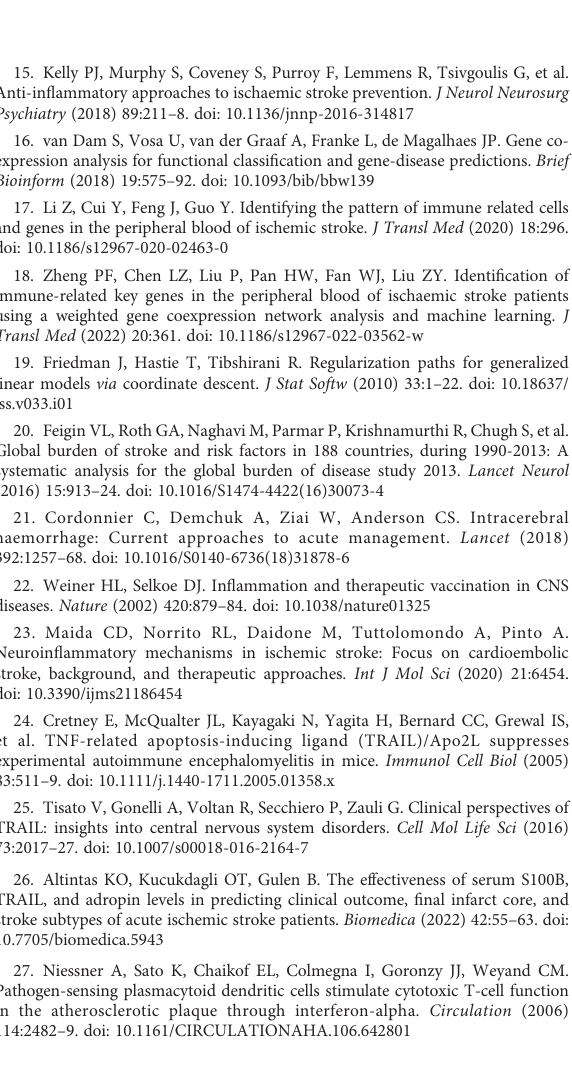
SUPPLEMENTARY FIGURE 2 The levels of TNFSF10, ID1, PAQR8, OSR2, PDK4, PEX11B, TNIP1, FFAR2, and JUN in each subtype of IS including LAA, CE, SAA, SUE and